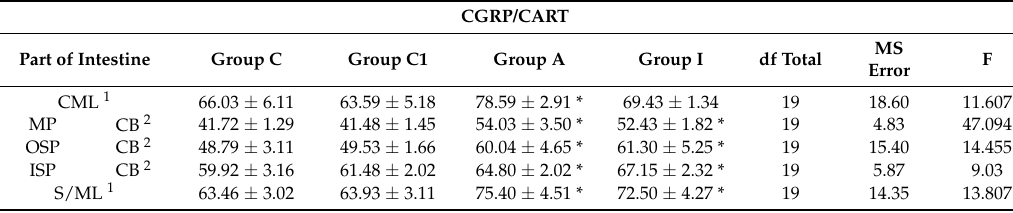
Table 4. Co-localization of CGRP with cocaine- and amphetamine-regulated transcript peptide